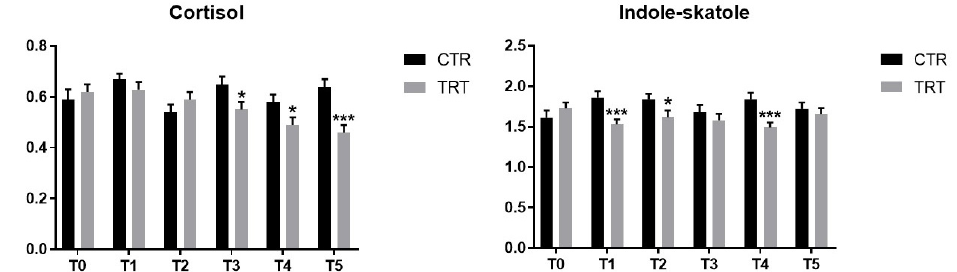
Figure 1. Concentration of cortisol (pg/mg) and indole/skatole (µmol/g) in the control (CRT) and treated (TRT) groups at each time point (T0 to T5). Graph bars with asterisks indicate significant differences between the dietary treatments within each sampling time; * = p < 0.05, and *** = p < 0.001. The alpha diversity of microbiota and mycobiota did not show any significant differ- ence between CRT and TRT groups (data not shown). The CRT samples were dominated by Pseudomonas (35% and 40%, respectively, at T0 time (12% and 1%, respectively), and Prevotella increased (from 5% to 12%, Figure 2). Dogs increasing from 28% at T0 to 46% at T5, Clostridiaceae decreasing from 11% at T0 to 1% at T5, and Prevotella increased from 7% to 13% at the end of the trial (Figure 3). When com- paring the gut microbiota between T0 and T5, we observed that Allobaculum , Blautia , Clos- tridiaceae , Dorea , Erysipelotrichaceae , Lachnospiraceae , Ralstonia , Ruminococcus , and Slackia were more abundant at T0 compared to T5 in both groups (Figure 3).